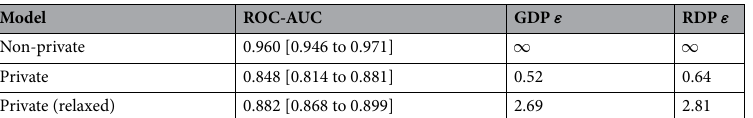
Table 1. Classification performance (measured as mean receiver-operator characteristic area-under-the-curve (ROC-AUC)) on the paediatric chest radiography binary classification dataset. Ranges in angled brackets. The non-private model significantly outperformed the private model in both the high-privacy setting and the relaxed privacy setting, while the private model trained with relaxed privacy guarantees significantly outperformed the private model with strict guarantees.